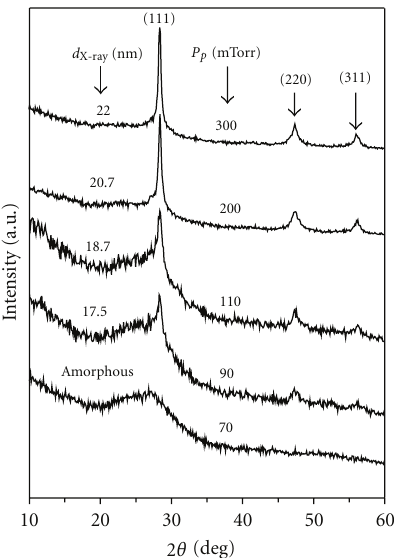
Figure 3: Low angle X-ray di ff raction pattern of some Si:H films deposited at various process pressure by hot wire method.